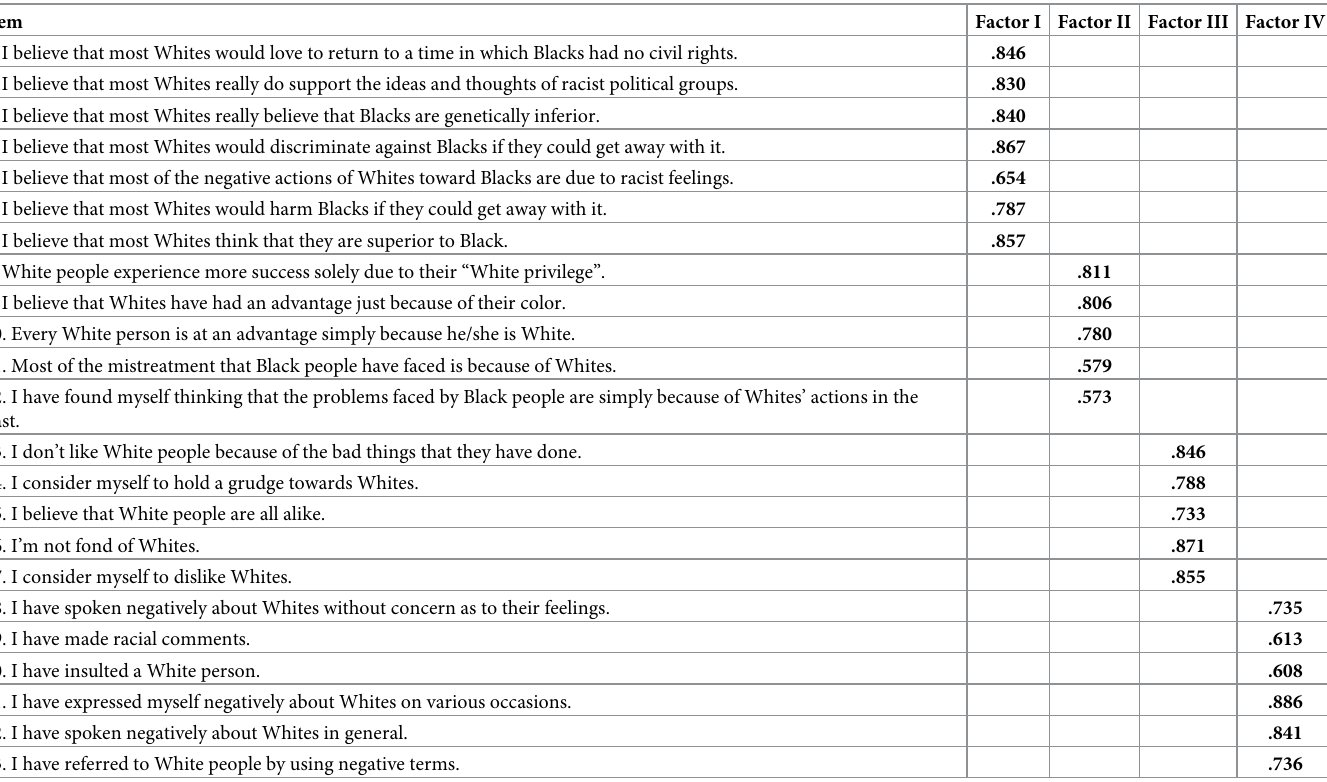
Table 6. Summary of CFA results (standardized factor loadings and item content) for AWB (Study 2, T2).